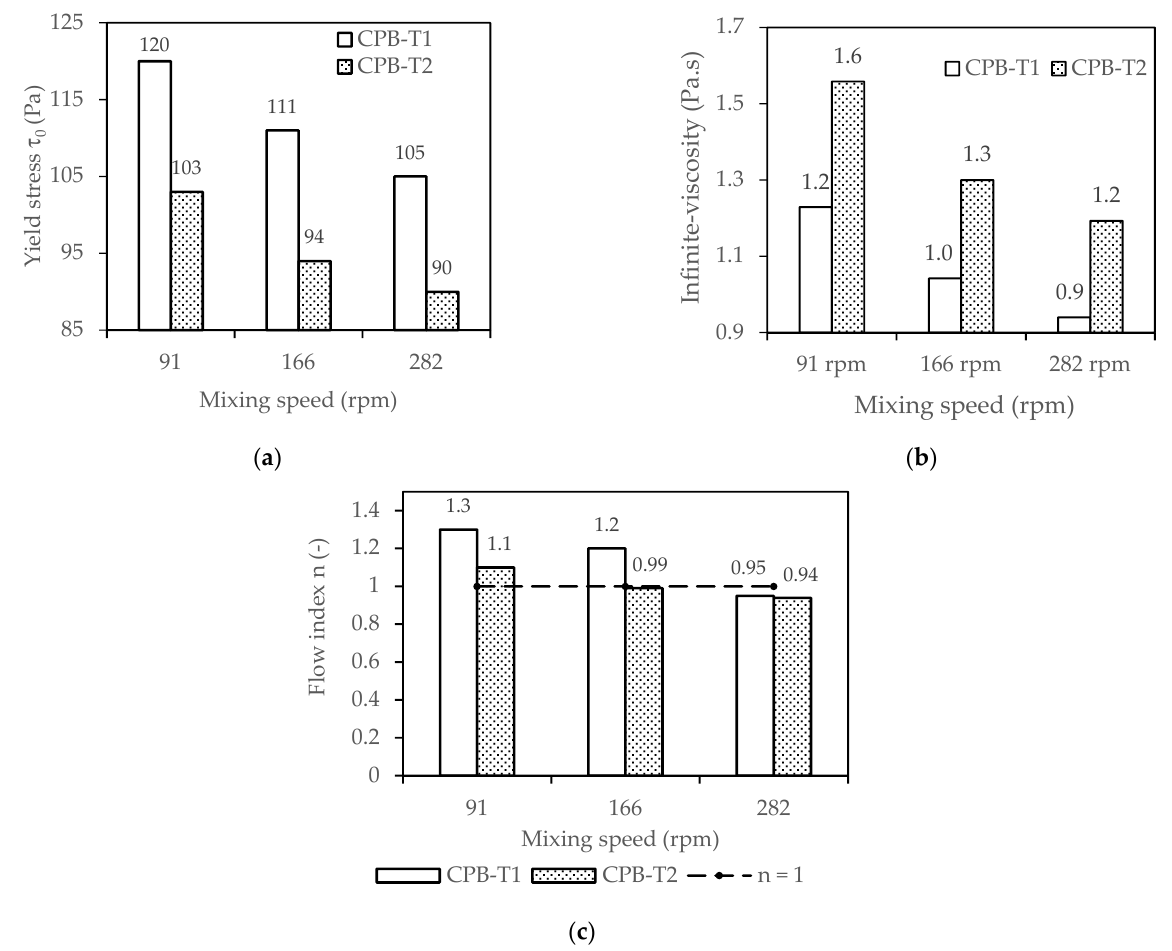
Figure 5. Effect of mixing speed on: ( a ) yield stress, ( b ) flow index and ( c ) infinite viscosity, for CPB-T1 and CPB-T2 mix- tures.